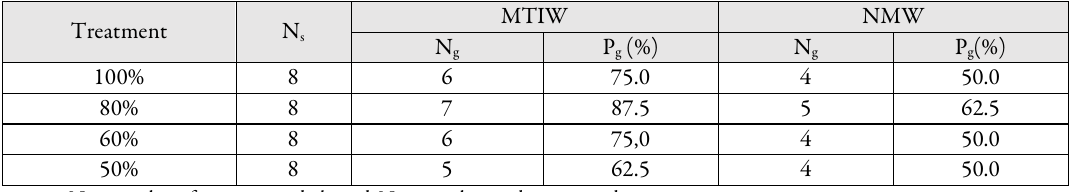
Table 3. Percentage germination of the popcorn